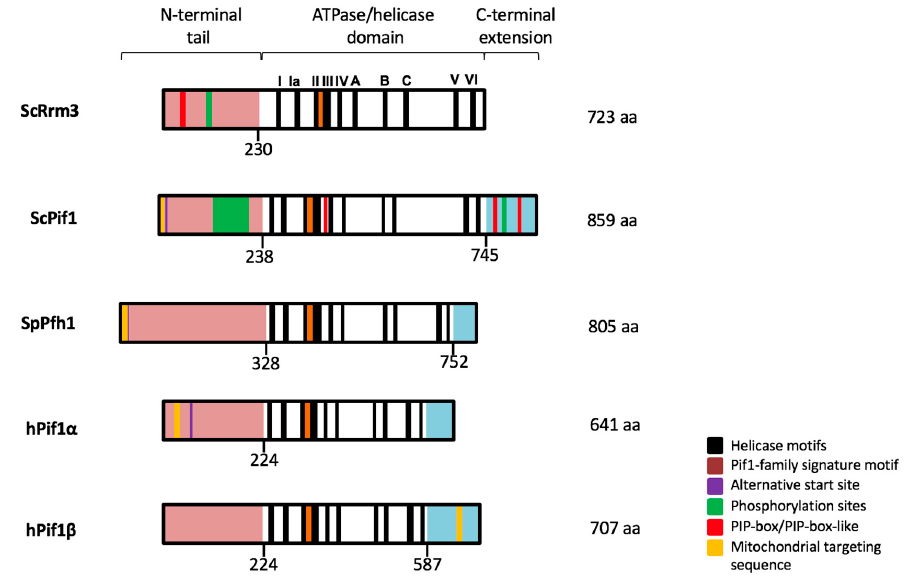
Figure 1. Structure and functional motifs of the yeast and human PIF1 family helicases. Saccharomyces cerevisiae expresses two members of the PIF1 family, Rrm3, and ScPif1, whereas Schizosaccharomyces pombe and higher eukaryotes express one. PIF1 helicases share the conserved ATPase/helicase domain and an intrinsically disordered N ‐ terminal tail of variable sequence. Post ‐ translational modification sites, proliferating cell nuclear antigen (PCNA) ‐ interacting protein (PIP) box and alternative start sites, which give rise to mitochondrial isoforms, are marked [9–14].